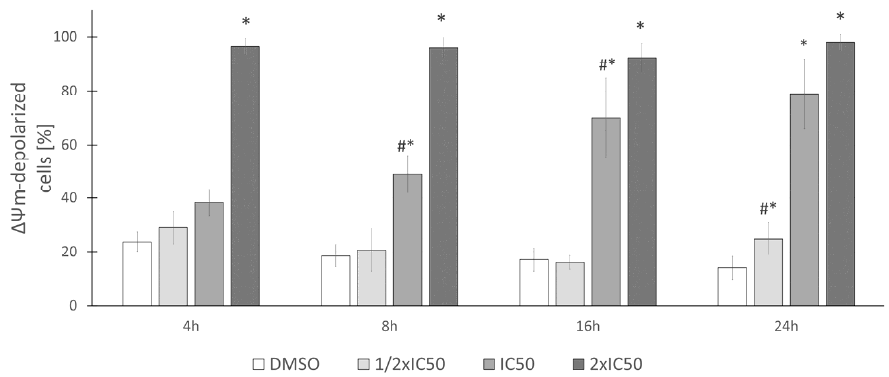
Figure 13. Rinderol induced alterations in mitochondrial membrane potential expressed as a percent of HeLa cell population with depolarized mitochondrial membrane. Data are the means ± SD of at least three independent replicates. Asterisk (*) indicates statistically significant differences ( p ≤ 0.05) between consecutive rinderol concentrations within the same incubation period (DMSO– 0.4%, 1/2 IC 50 –2.83 µ g/mL, IC 50 –5.66 µ g/mL, 2 × IC 50 –11.32 µ g/mL). Grids (#) indicate results which were significantly different ( p ≤ 0.05) in comparison to the previous time point of the same rinderol